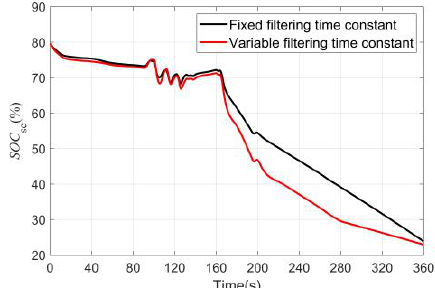
Figure 21. Comparison of the supercapacitor’s SOC value change under constant and variable filter time constants.